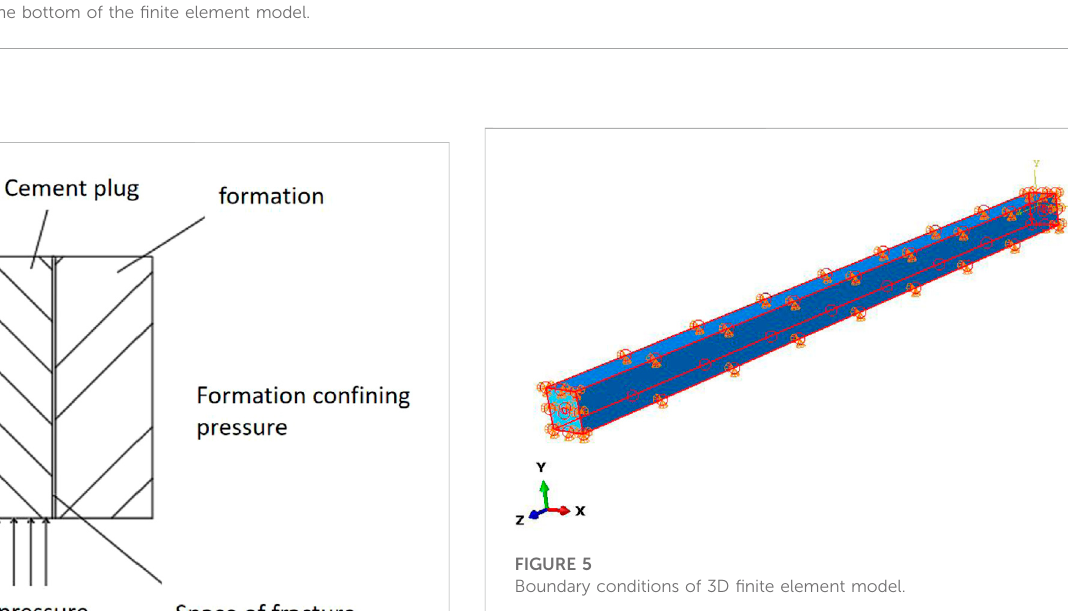
FIGURE 3 Grid diagram of the bottom of the fi nite element model.